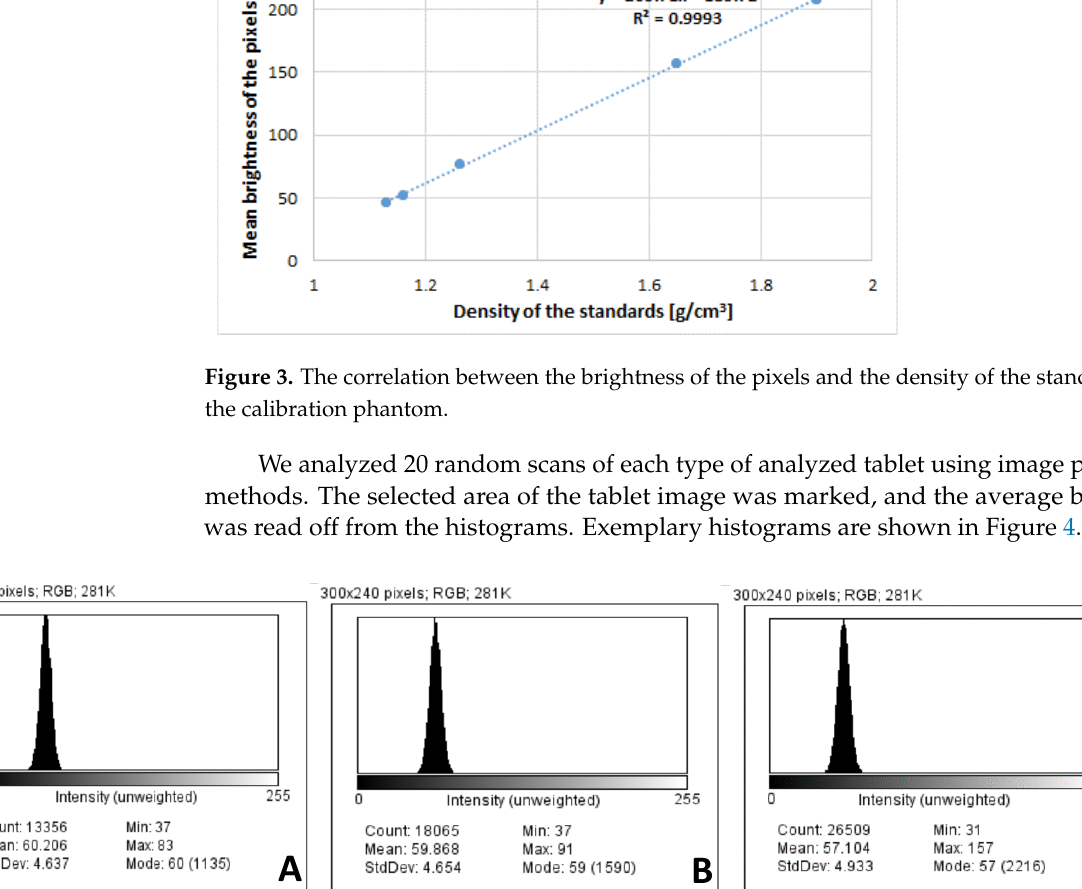
Table 4. The density of the analyzed tablet interiors.